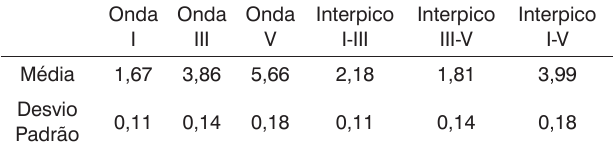
Tabela 2. Médias e desvios padrão (ms) das latências ab- solutas e intervalos interpicos dos PEATE de adultos jovens normo-ouvintes, conforme calibração biológica do hospital universitário.